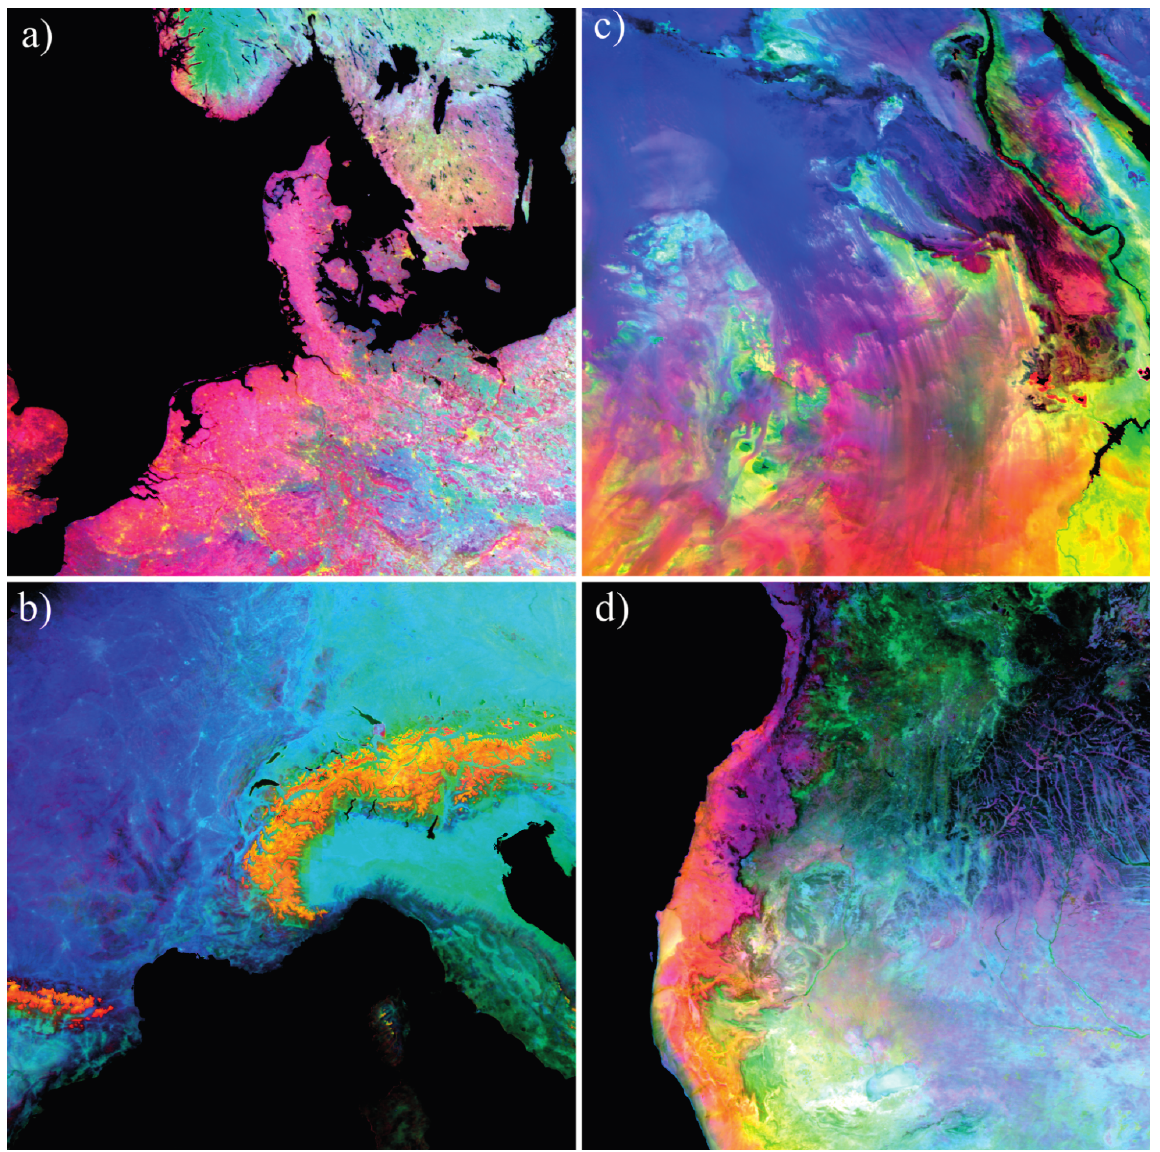
Figure 6. Selected ACP color composite of single tiles (h xx v yy ) ( a ) θ -YAST-RMSE of (h 18 v 03 ); ( b ) Nighttime RMSE-YAST- θ ( h18v04 ); ( c ) RMSE-MAST-YAST (h 20 v 06 ); ( d ) MAST-YAST-RMSE (h 19 v 10